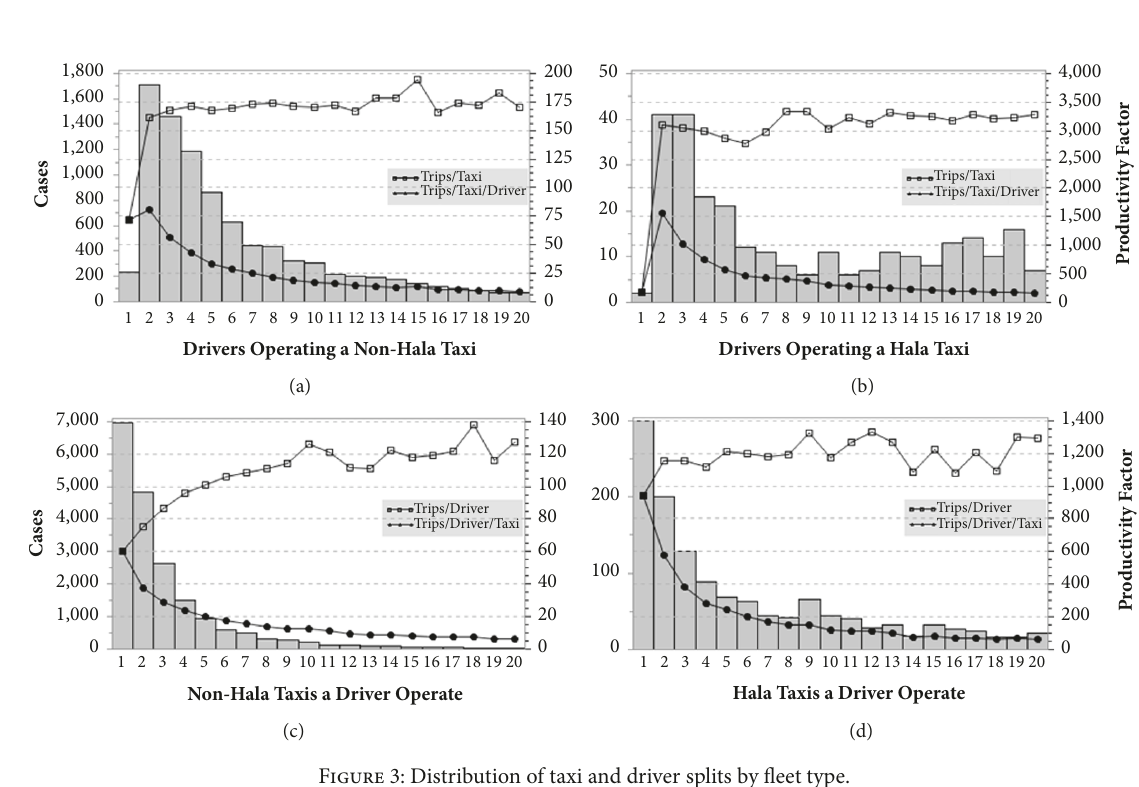
Figure 3: Distribution of taxi and driver splits by fleet